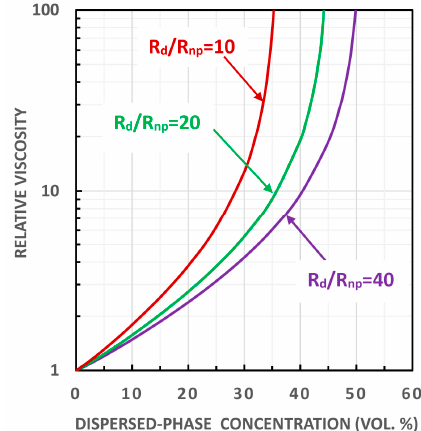
Figure 8. Model predictions of relative viscosity versus dispersed-phase (bare droplets) concentration (vol. %) of oil-in-water (O/W) Pickering emulsions for different ratios of bare droplet radius to nanoparticle radius.